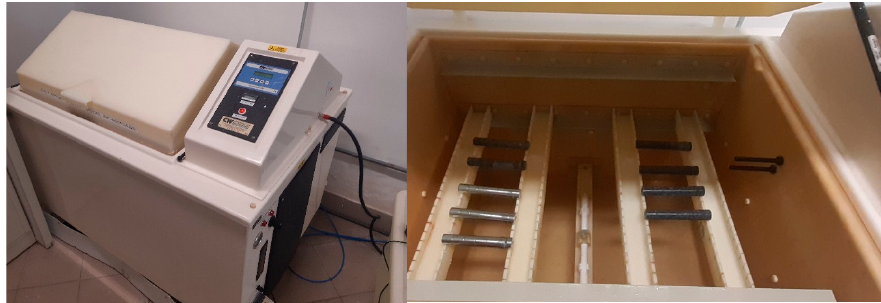
Figure 9. Salt spray cabinet SF/450/CASS and the parts during the corrosion test.